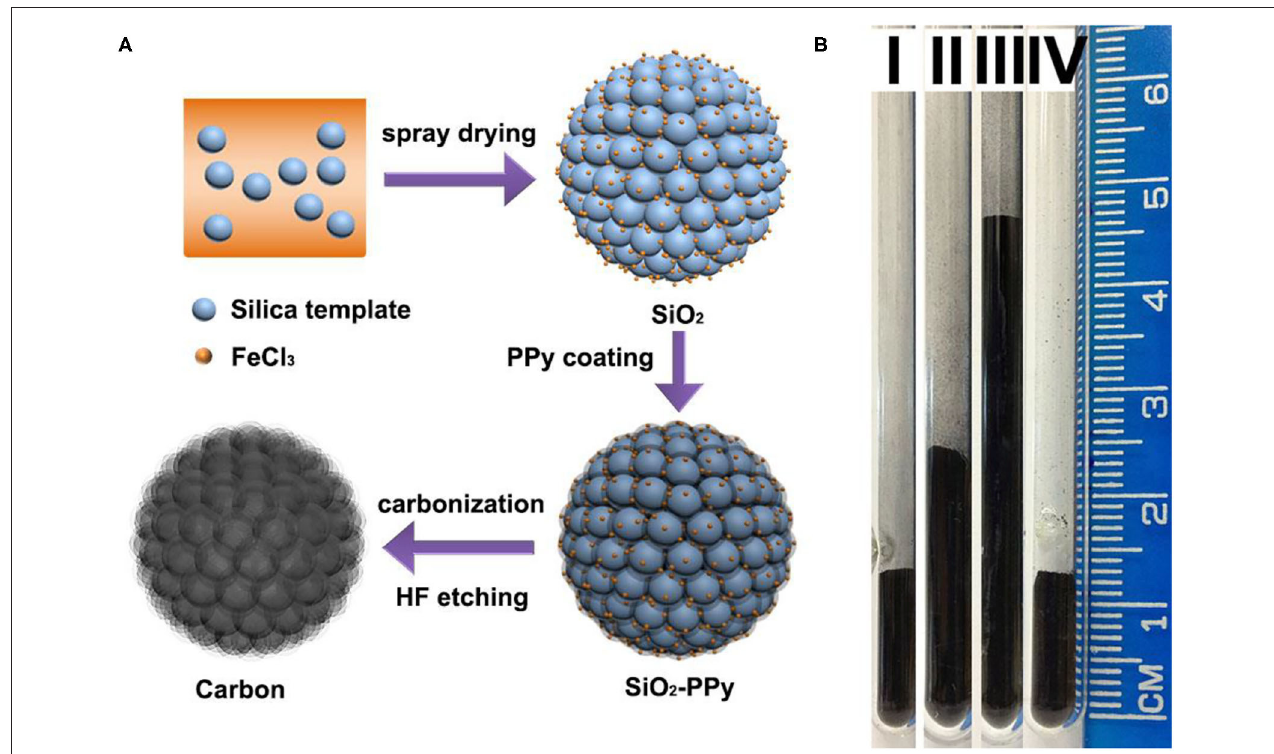
FIGURE 1 | (A) Illustration of the synthesis approach of MC-7-SD, (B) the apparent density of (I) MC-7-SD, (II) MC-7-AD, (III) MC-7-FD, and (IV) activated carbon materials. The mass of each material is 50 mg.